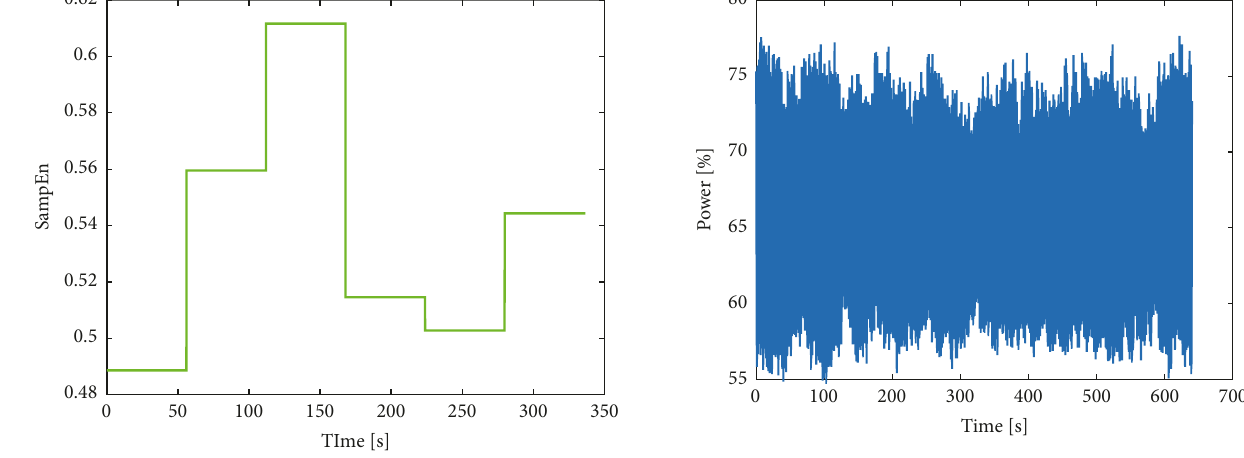
Figure 24: Ringhals Case 9 cycle 14 LPRM1.